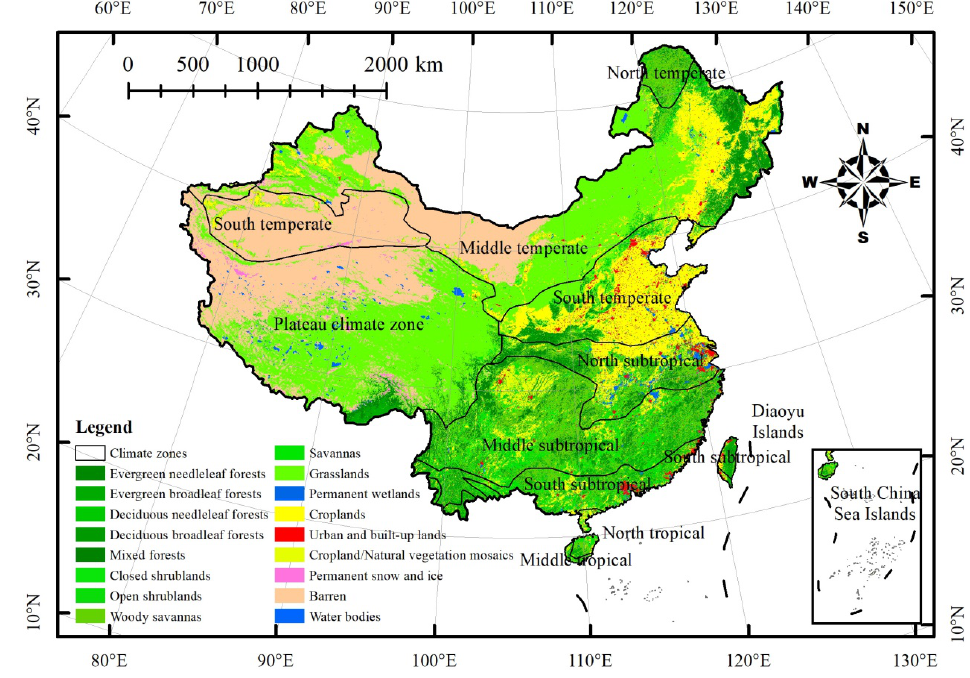
Figure 2. Land use/land cover (LULC) spatial distribution map. Figure 2. Land use/ land cover (LULC) spatial distribution map. Table 2. Proportion of land use/land cover (LULC) types in different climate Table 2. Proportion of land use/land cover (LULC) types in different climate zones.